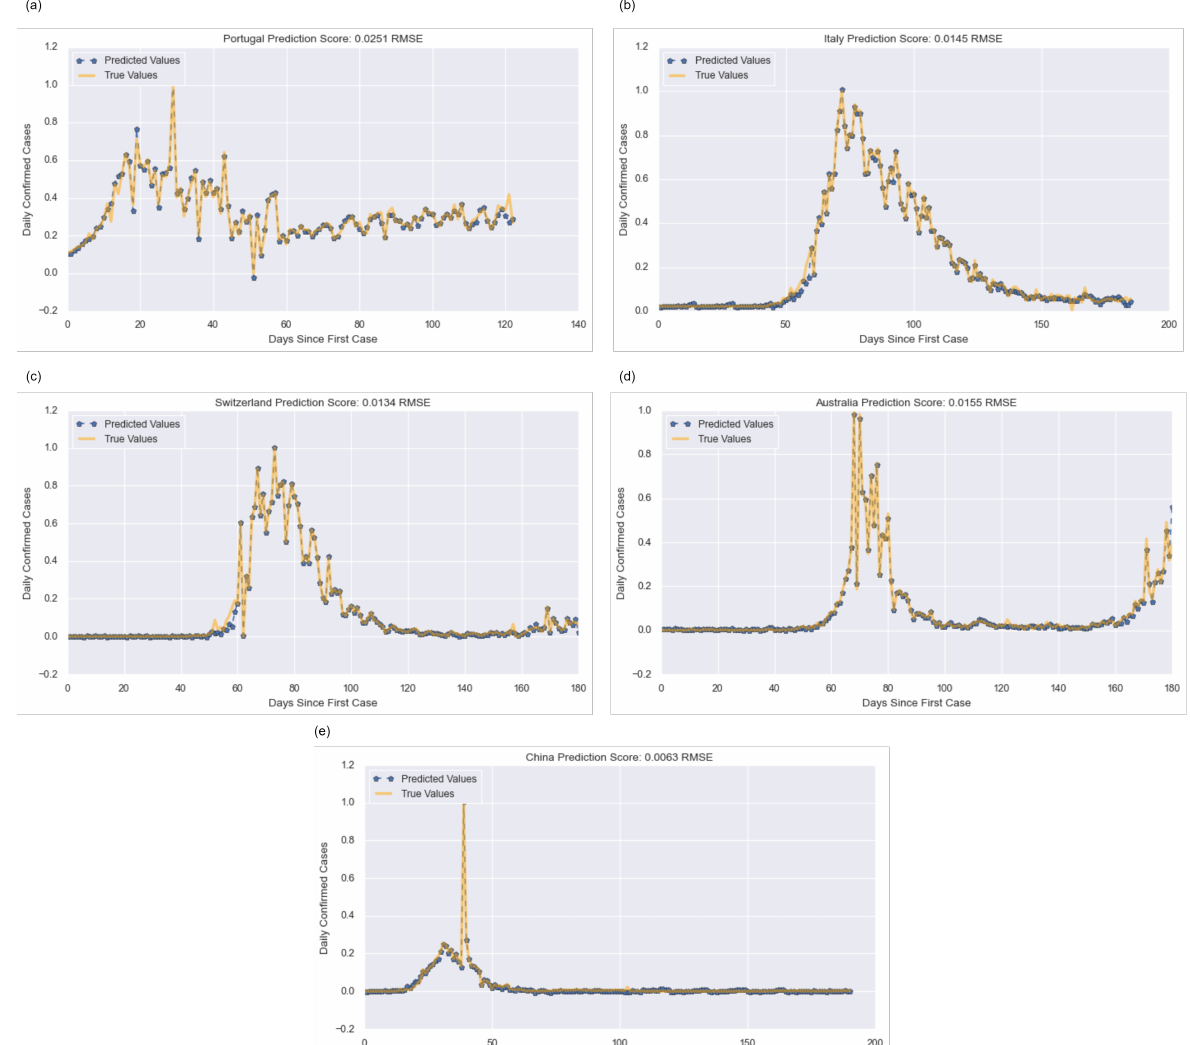
Figure 15. Validation results of LSTM models for daily COVID-19 cases predictions for countries (Portugal (a), Italy (b), Switzerland (c), Australia (d) and China (e)) of Impact